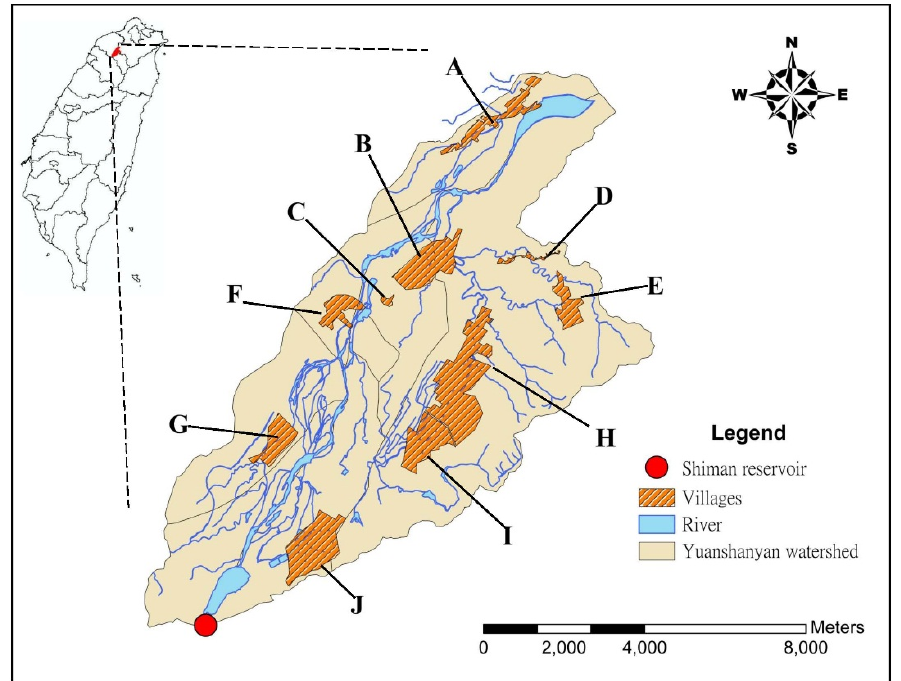
Figure 1. Locations of 10 villages for (low impact development) LID implementation in Yuanshanyan